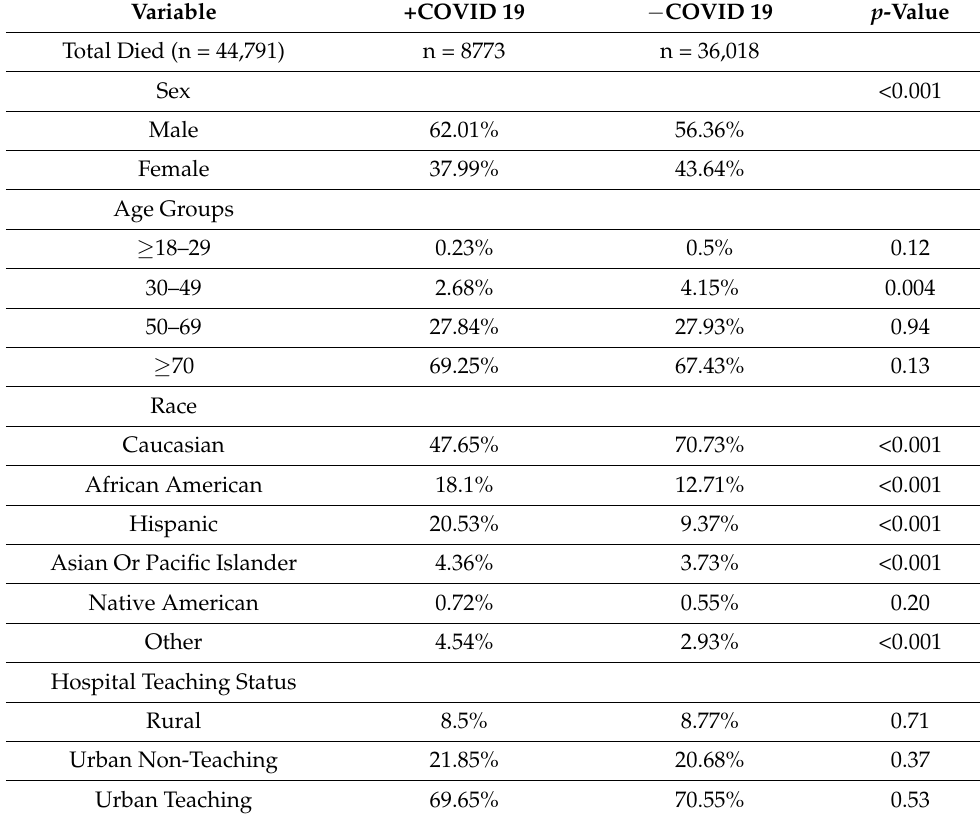
Table 4. NSTEMI Mortality Sub-Group Analysis Based on COVID-19 Status.